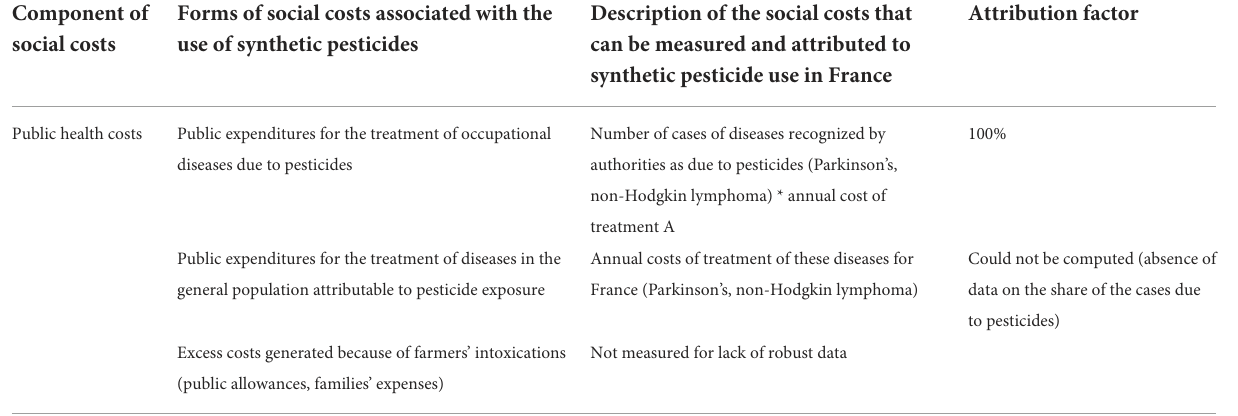
TABLE 3 Forms and description of the public health costs associated with the use of synthetic pesticides in